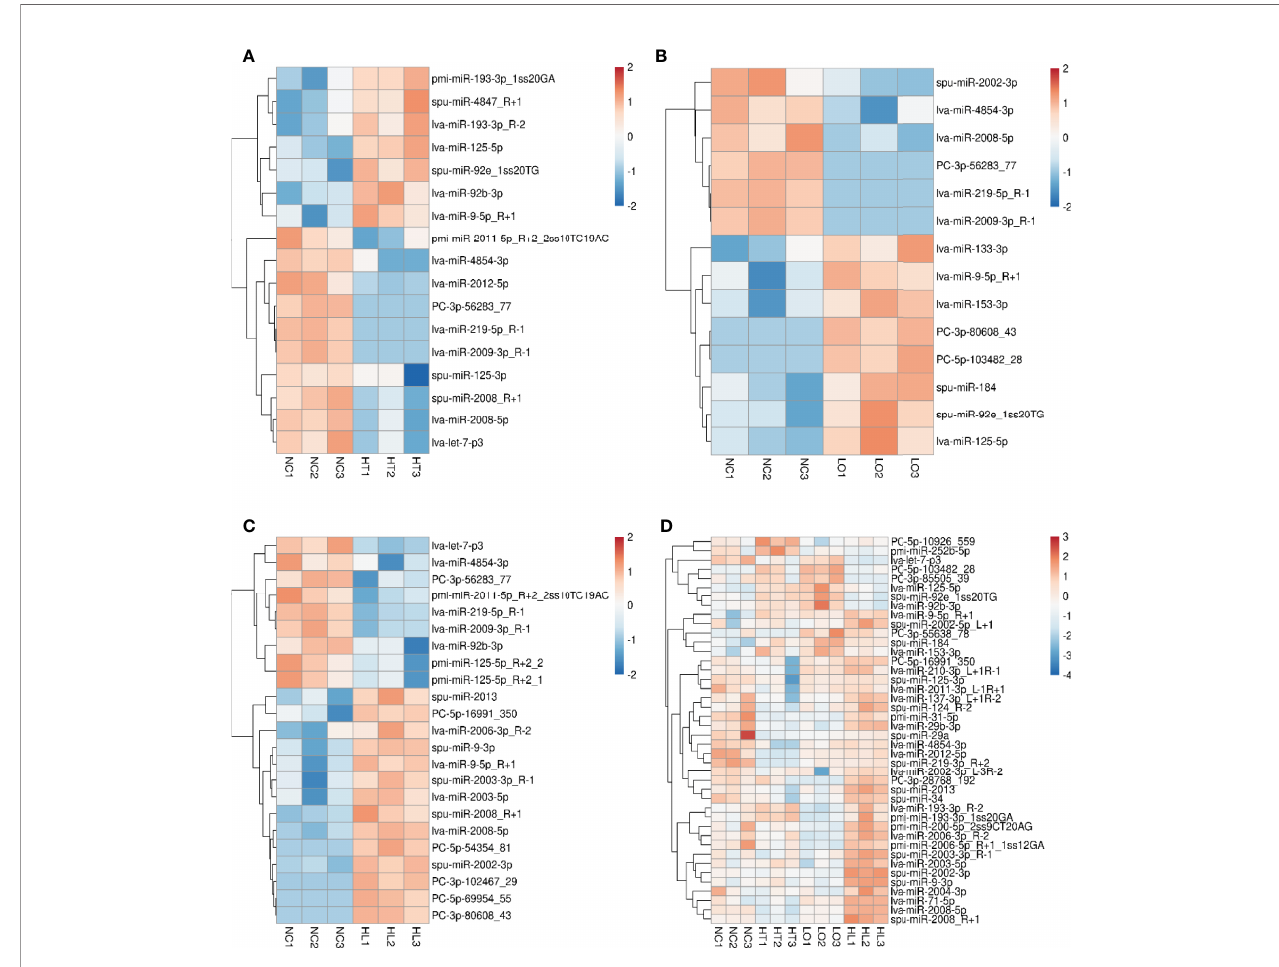
FIGURE 3 | Differentially expressed miRNAs (DEMs) in the four groups. (A) HT vs NT, (B) LO vs NT, (C) HL vs NT, (D) DEMs (non-repetitive) in the pairwise comparison among the three treatments ( P < 0.05). All red rectangles indicate higher levels of miRNAs, and blue rectangles indicate lower levels of miRNAs. Color scale bar represents log 2